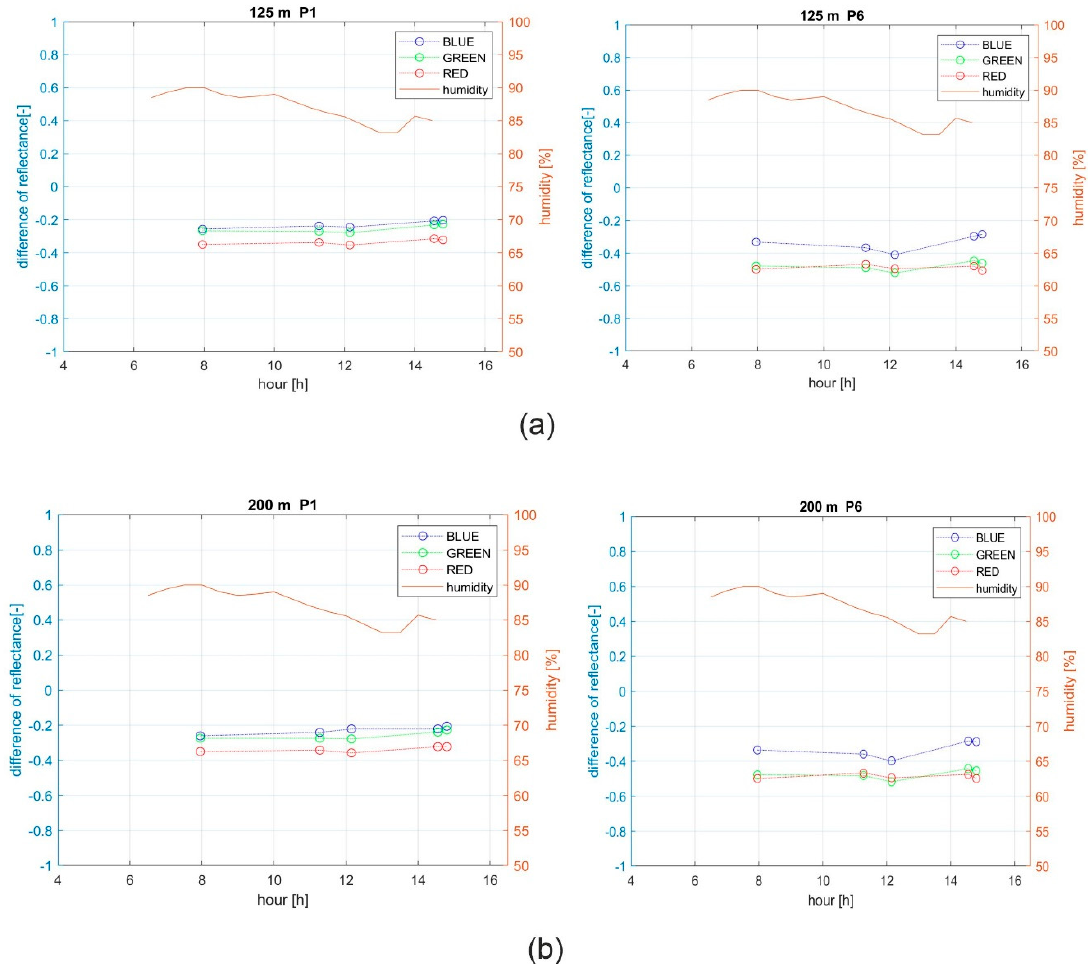
Figure 18. Air humidity and residuals from the theoretical value of reflectance for 2% and 95% tests for data obtained at ( a ) 125 m and ( b ) 200 m in poor weather conditions (Mieruniszki area, November 22, 2018).